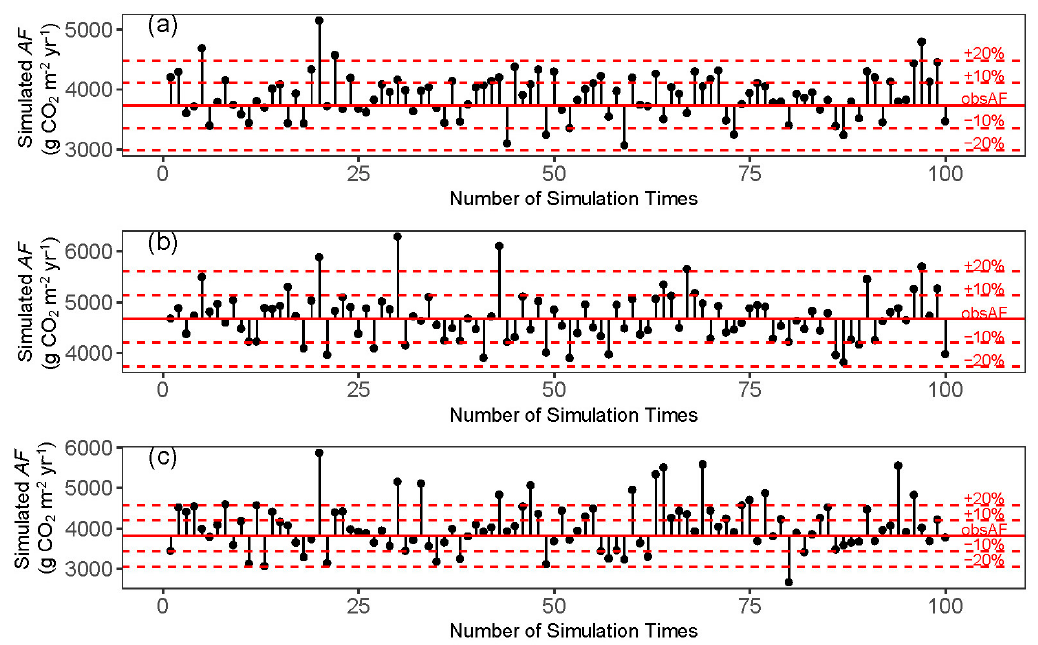
Figure 12. Difference between continuous observed annual soil respiration and simulated annual soil respiration using the present method with four observations. ( a ) Chamber 1; ( b ) Chamber 2; ( c ) Chamber 3. The solid red horizontal line denotes the annual soil respiration using 8592 observations per year (obsAF); the black dots denote the simulated annual soil respiration using the 4 random observations per year required by Equation (B4), and simulation was carried out 100 times using each chamber data; the vertical black lines denote the difference between the simulated annual soil respiration and obsAF; the red dashed lines denote 4 references, and from top to bottom are 1.2, 1.1, 0.9, 0.8 times the obsAF, respectively. Raw data was obtained from Perez-Quezada et al. [56].